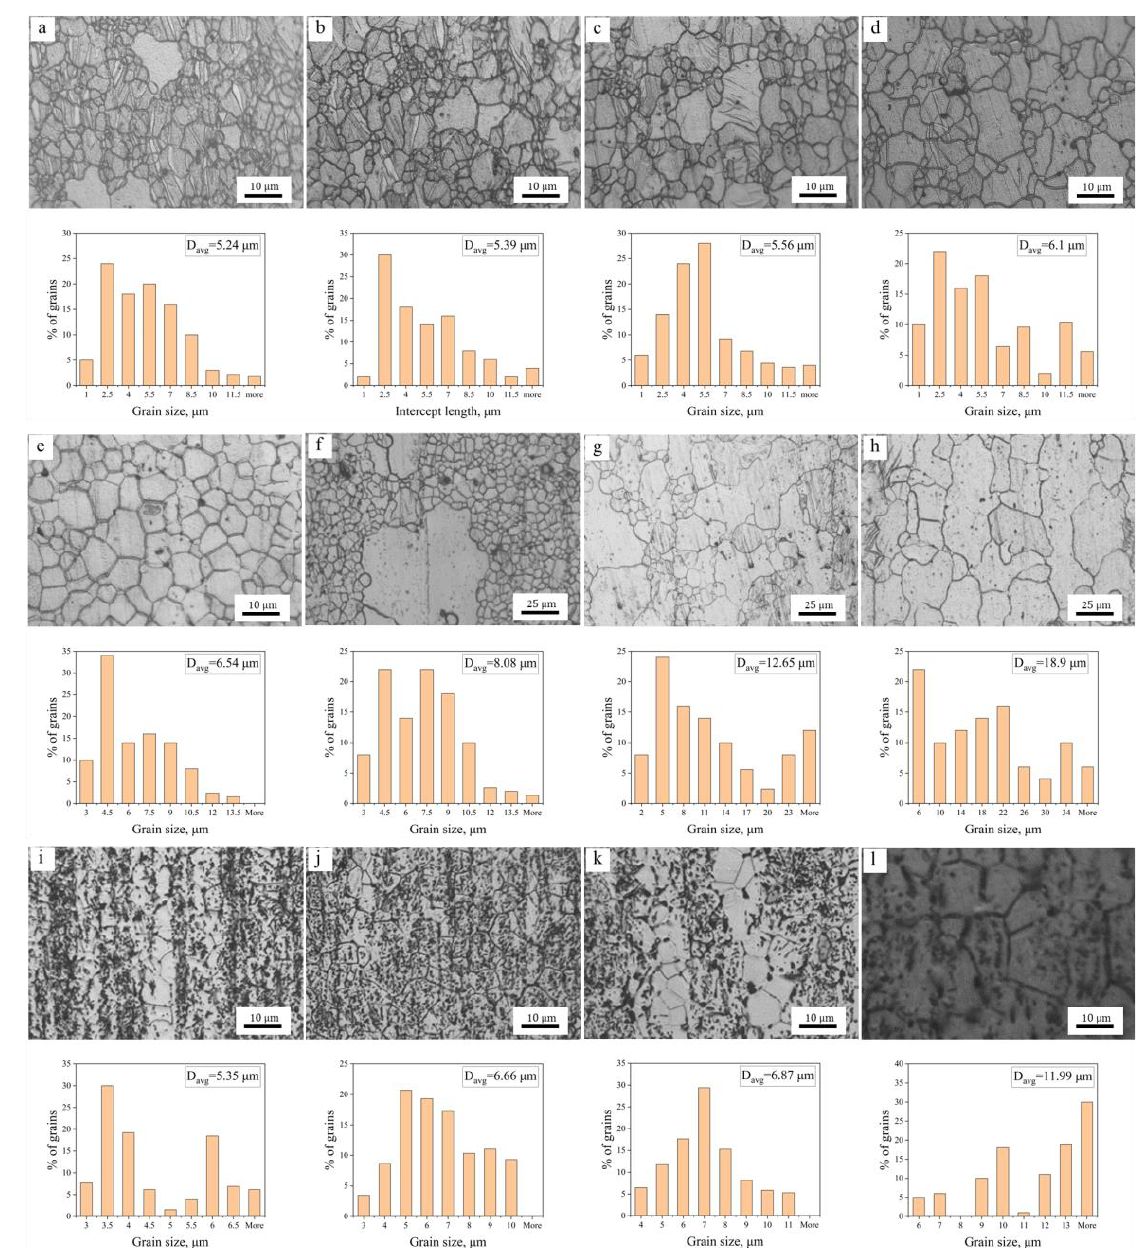
Figure 2. Optical micrographs of ( a – d ) AZ31, ( e – h ) AZ61, ( i – l ) AZ91 annealed at 300 °C for 12, 24, 48, and 72 h. The corresponding histograms of the particle size distribution are shown below each micrograph.